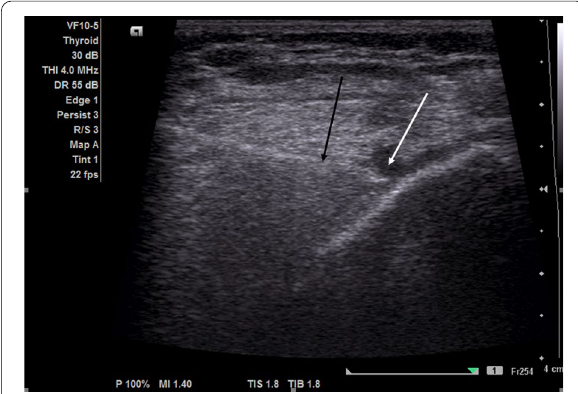
Fig. 2 US image of the needle as an echogenic linear structure (black arrow) within the supra‑patellar bursa (white